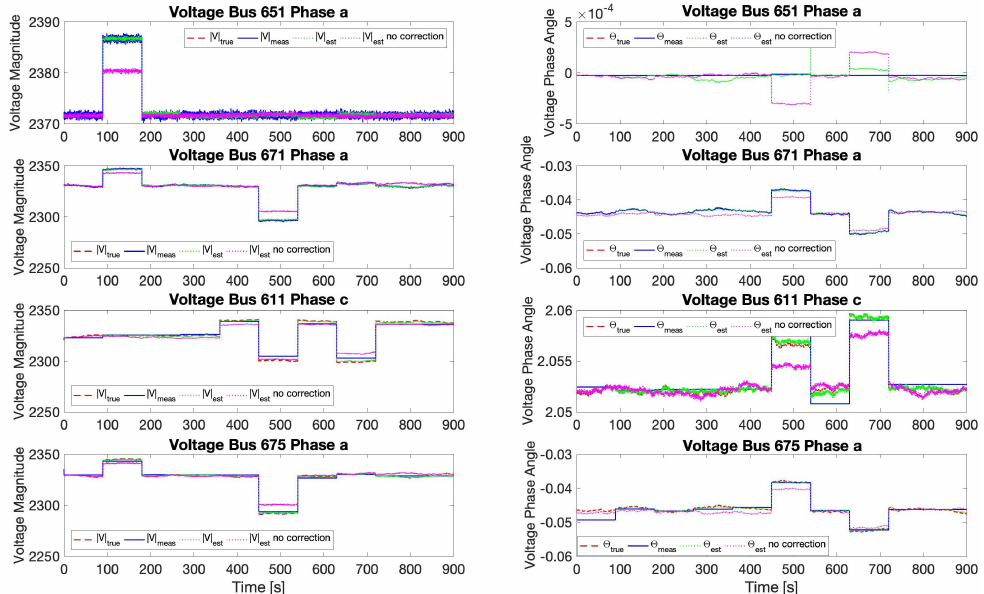
Figure 9. Comparison of true, measured, and estimated values of bus